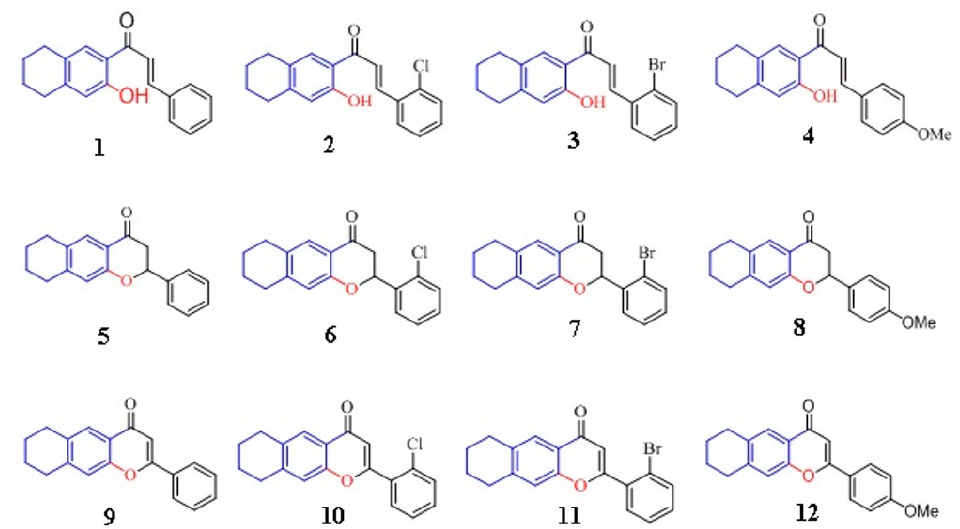
Figure 1. Flavonoids structures (chalcones ( 1 – 4 ), flavanones ( 5 – 8 ), and flavones ( 9 – 12 )).